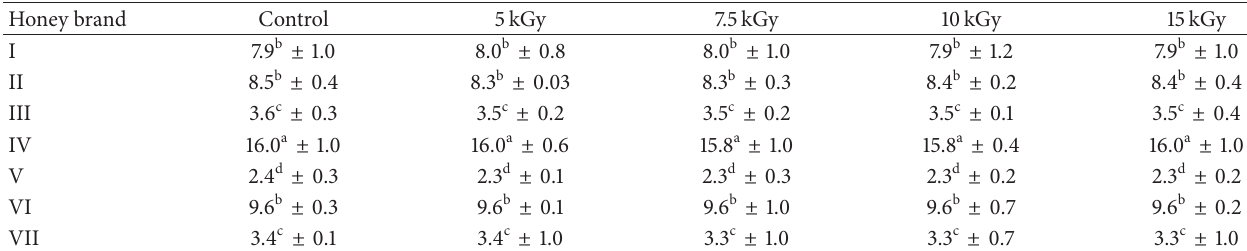
Table 2: Effect of gamma radiation treatment on viscosity (Pa ⋅ s ± SD x ) of honey measured at 25 ∘ C. Honey